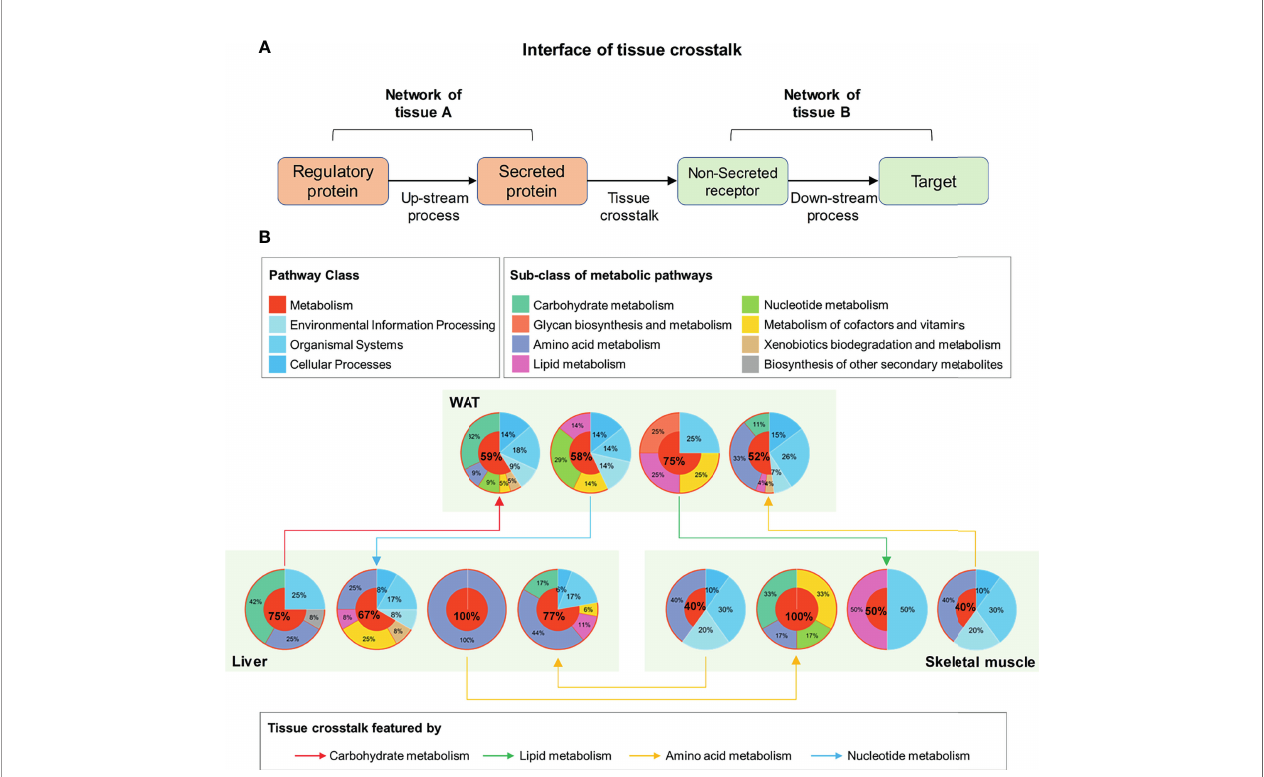
FIGURE 5 | Functional interpretation of tissue crosstalk interface relevant to IR. (A) Schematic diagram of cross-tissue interface; (B) Functional classi fi cation of up and downstream processes in the interface of IR.